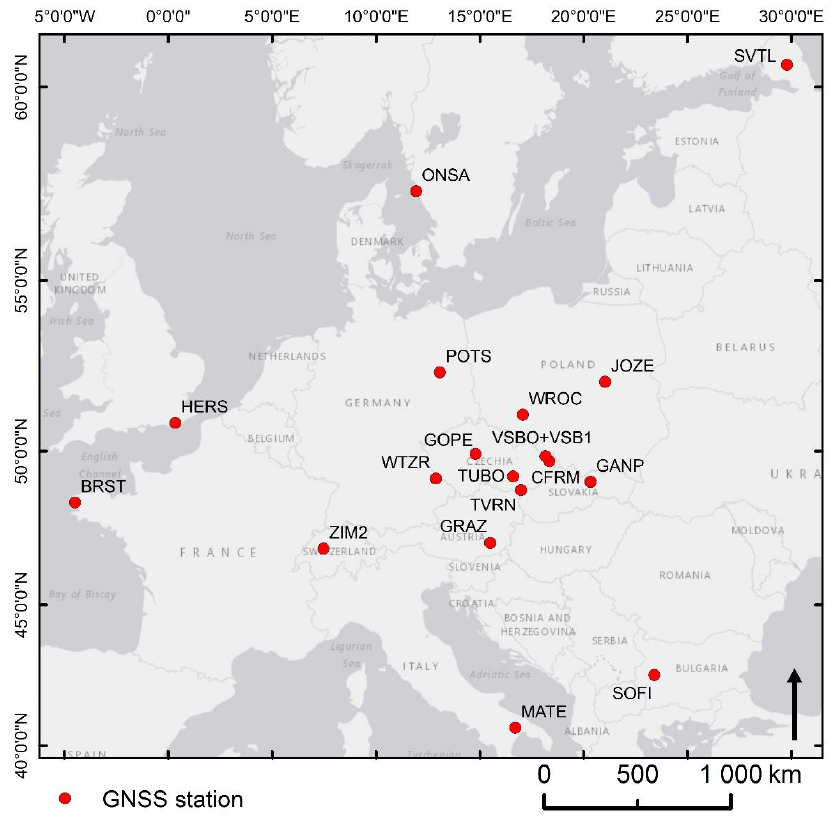
Figure 9. Network of GNSS reference stations used for processing.